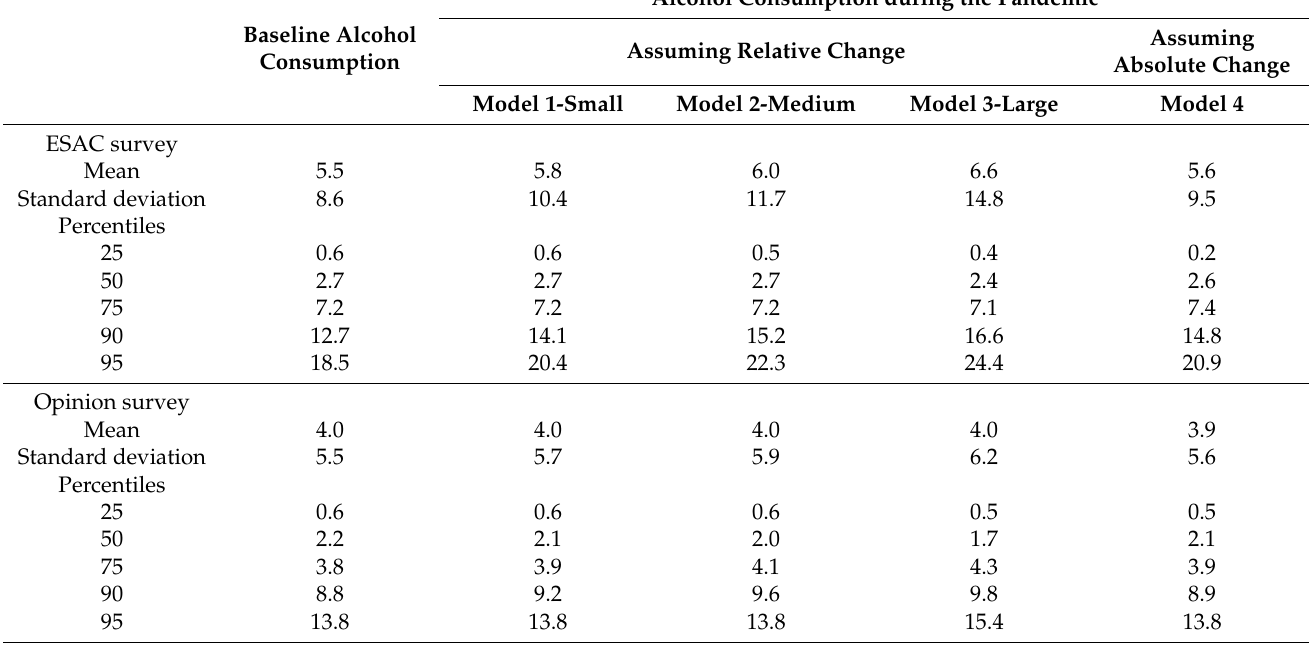
Table 2. Mean, standard deviation and percentiles of alcohol units per week for baseline alcohol consumption and estimates for relative and absolute change. ESAC survey and Opinion survey ( n =